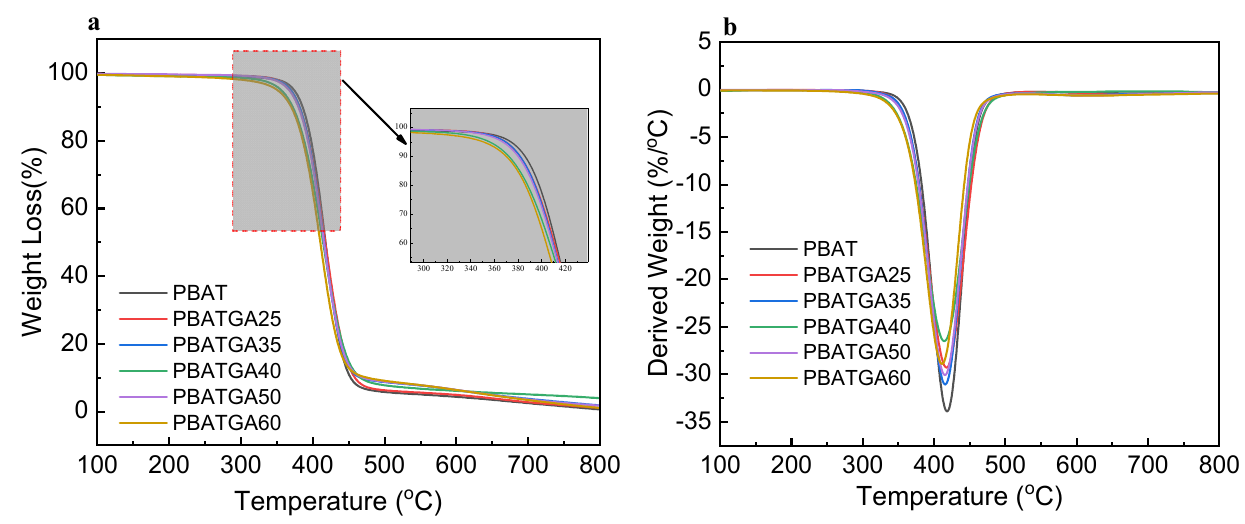
Figure 5. Thermal decomposition curve of PBAT and PBATGAs.